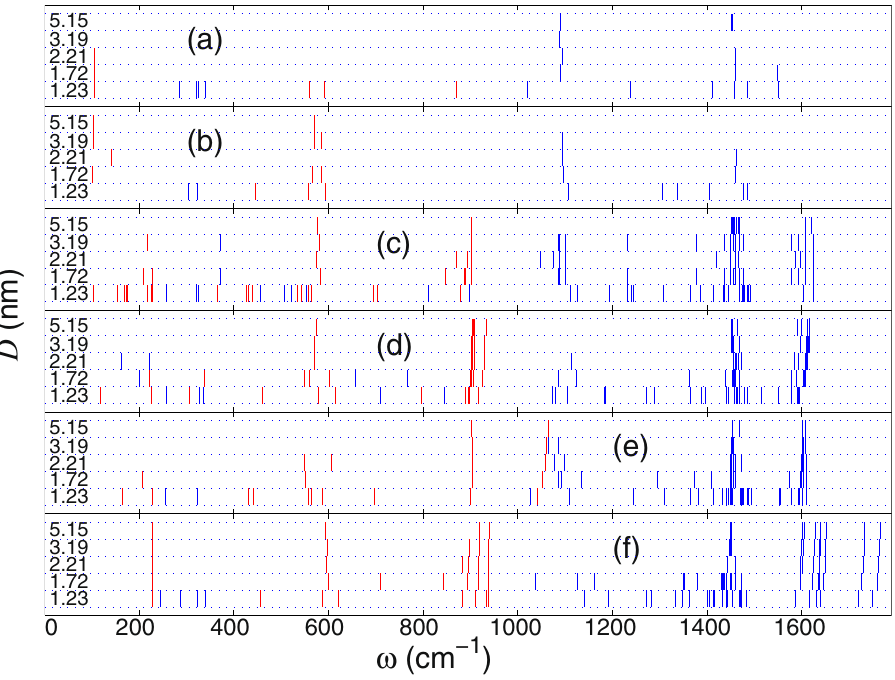
Figure 16. Eigenfrequency spectrum of the vibrational local models supported by the edge defects ED + 2 ( a ), ED − 2 ( b ) and the central point defects V 2 (585) ( c ), SW(5577) ( d ), V 1 (59) ( e ), and I 2 (7557) ( f ). Nanoribbon has the width of D = 1.23, 1.72, 2.21, 3.19 and 5.15 nm, respectively. Red color marks the eigenfrequencies of out-of- plane vibrational modes, and blue color marks in-plane oscillatory